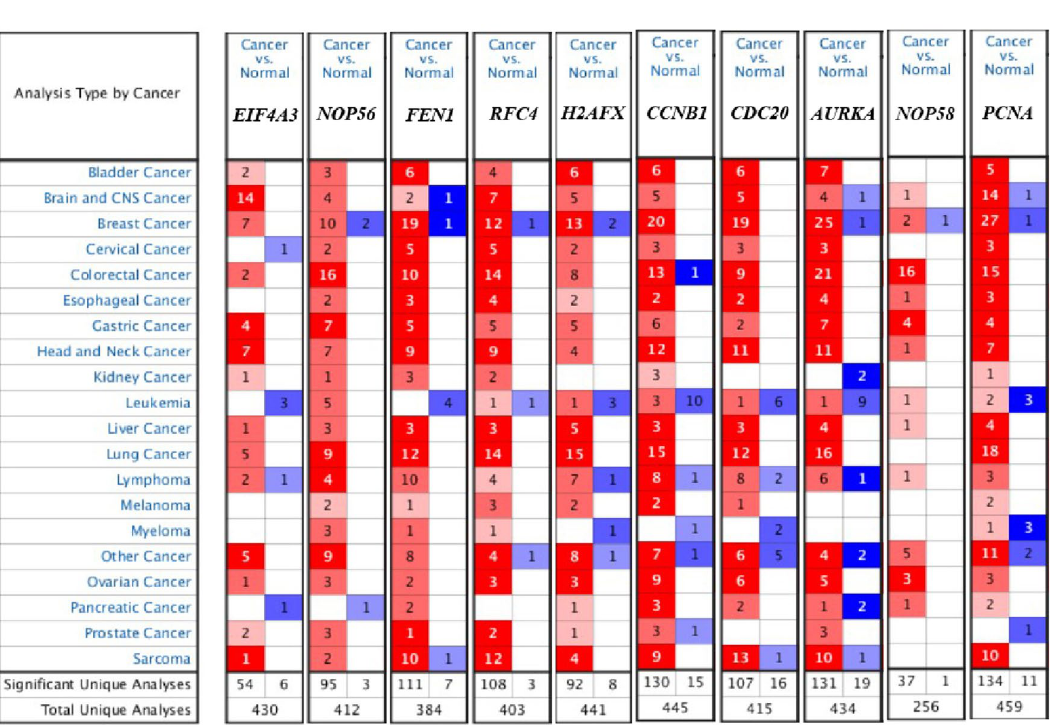
Figure 8. The results returned from Oncomine database. The row corresponds to cancer, and the column corresponds to gene. The red square represents that the gene was up-regulated in cancer, the blue square represents that the gene was down-regulated in cancer, and the value in the square represents the number of related references. This figure was drawn with Oncomine 15 (https ://www.oncom